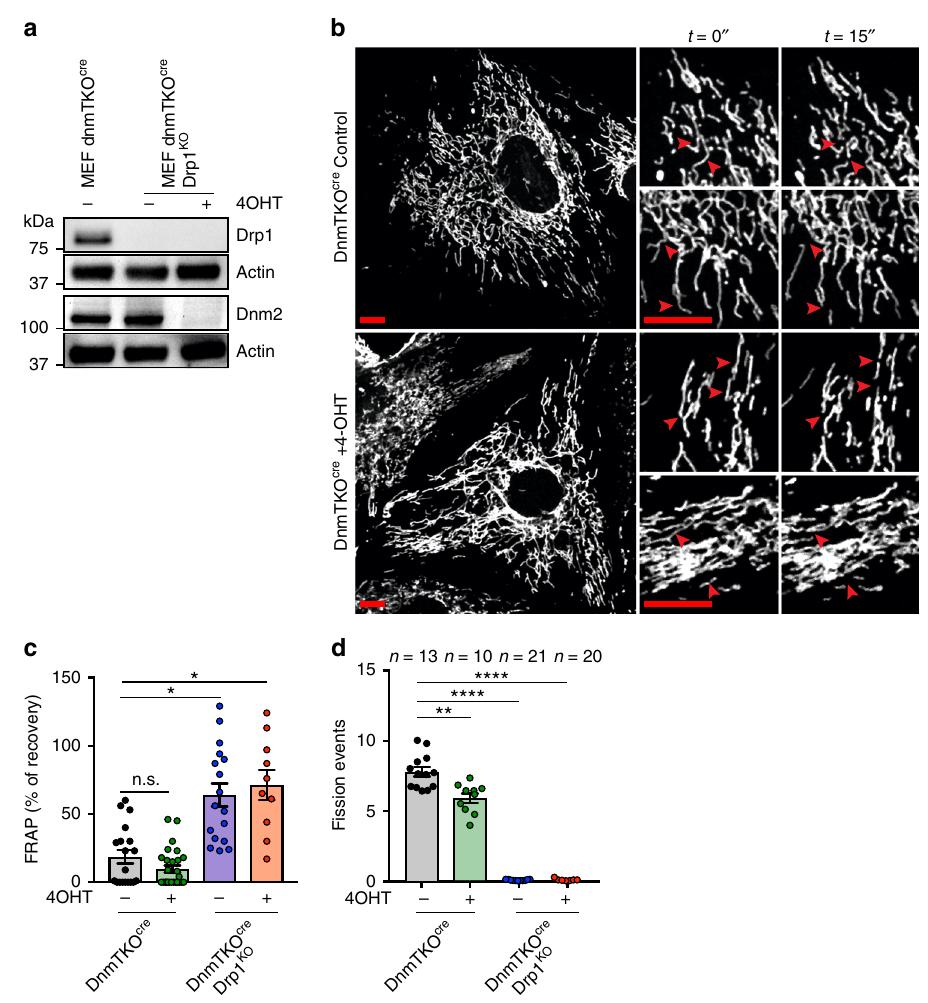
Fig. 3 Loss of Drp1 is dominant to loss of dynamins 1,2,3. a Western blot analysis of MEF DnmTKO cre , DnmTKO cre + Drp1 KO control and 4-OHT induced cells on whole cell lysates. Actin was used as a loading control. b Representative confocal image frames depicting mitochondrial morphology and fi ssion events of MEF DnmTKO cre control and knockout (4-OHT induced) cells. Two enlargements on the right of each panel show fi ssion events over the course of 15 s (red arrowheads). Scale bar = 10 µ m. c FRAP analysis of mtDendra2 in MEF DnmTKO cre , DnmTKO cre + Drp1 KO control and 4-OHT induced cells. n obtained from three independent experiments. Data represents the mean ± S.E.M.; n.s., not signi fi cant; * p < 0.05. One-way ANOVA with